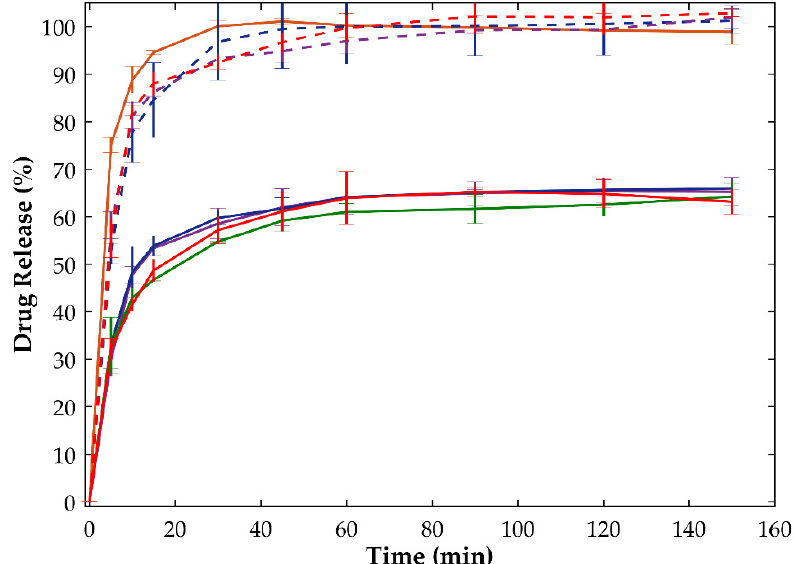
Figure 10. Dissolution tests conducted with crystalline olanzapine:saccharin (physical mixture, green solid line), co-amorphous olanzapine:saccharin (physical mixture, orange solid line) and granulated olanzapine:saccharin formulation using 10% (solid line) and 25% of water (dashed line). Drying temperature applied to samples: 40 °C (blue), 65 °C (purple) and 90 °C (red).